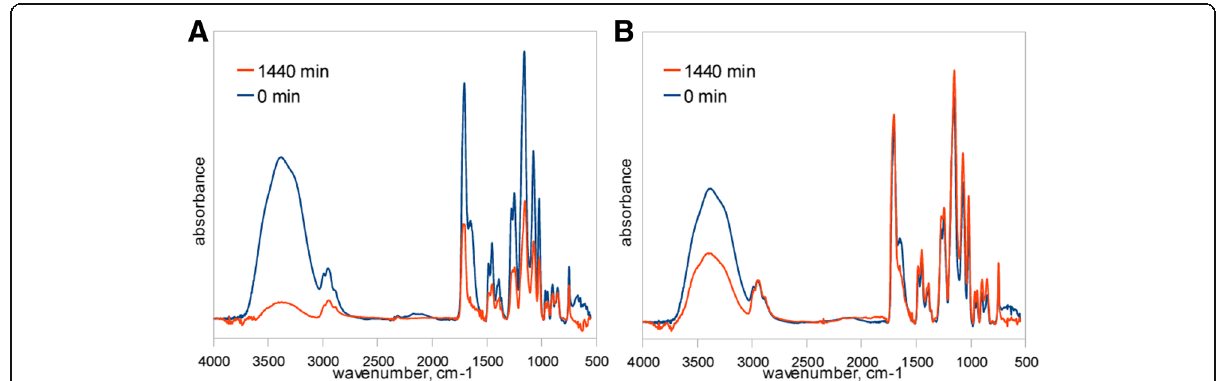
Fig. 2 FTIR spectra of material subjected to ( a ) deionized water and ( b ) saline